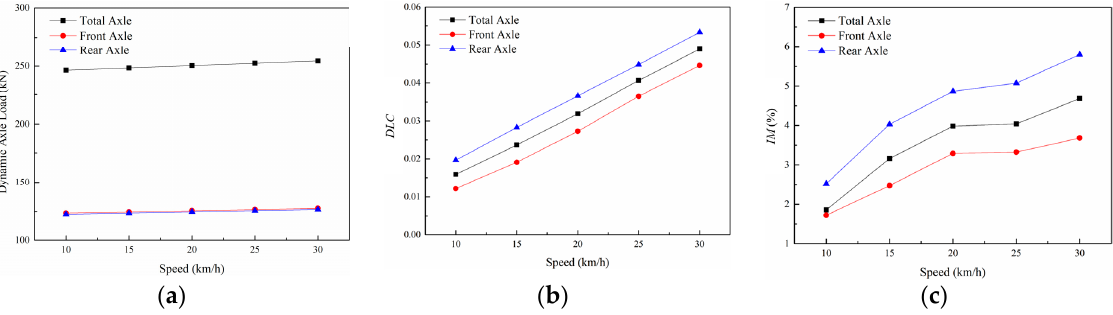
Figure 15. Dynamic axle load in straight road sections with different speeds under simulation conditions. ( a ) Dynamic axle load. ( b ) DLC . ( c ) IM